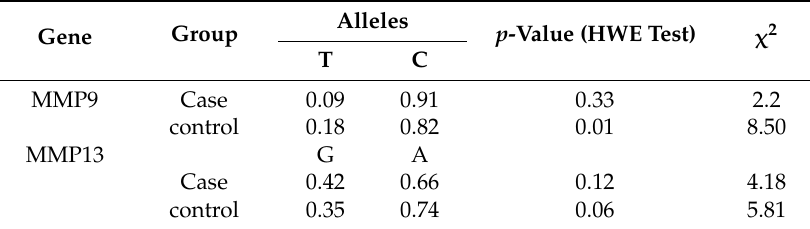
Table 5. Allelic frequency and logistic regression analysis data of MMP-9 and MMP-13. Gene